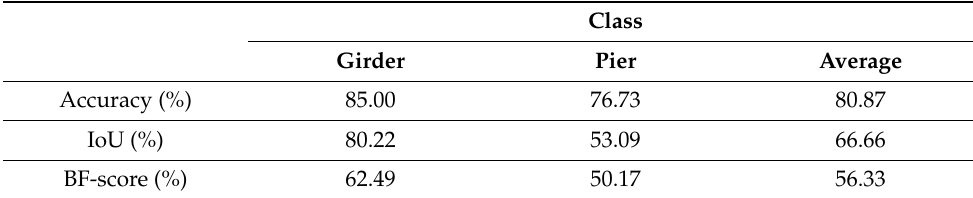
Table 5. Semantic segmentation results.